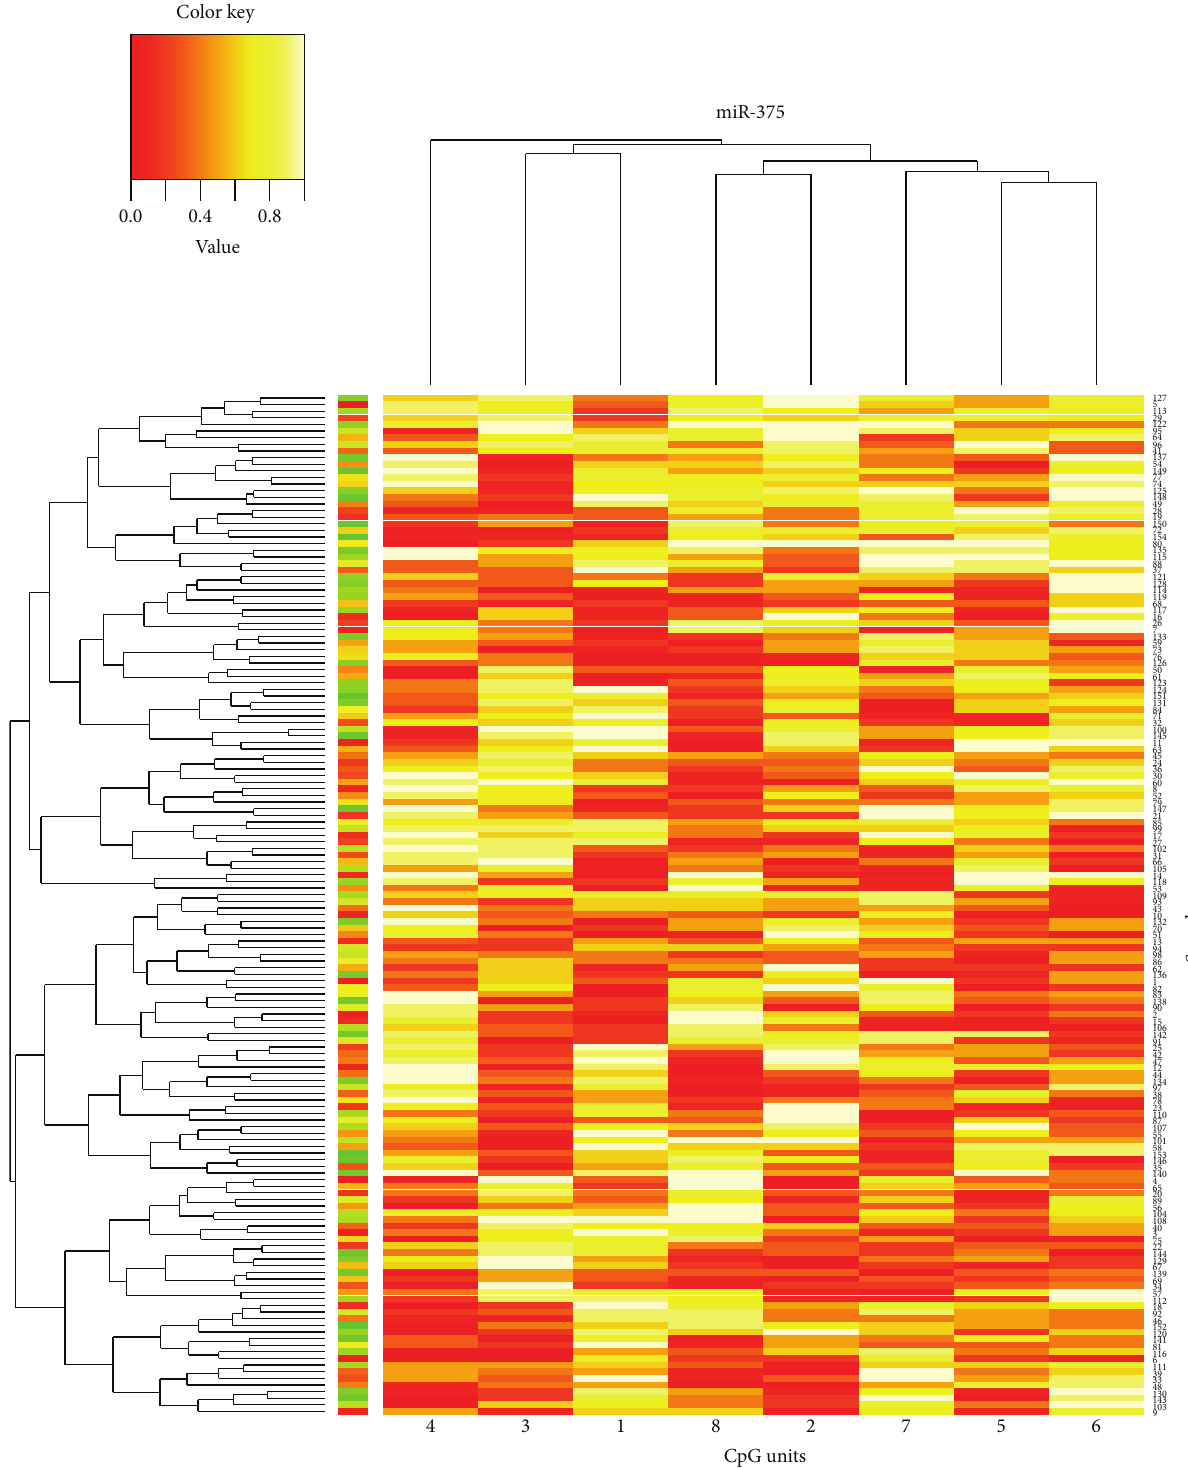
Figure 2: Hierarchical clustering of miR-375 methylation profiles in Kazak and Han T2DM samples. MassARRAY analysis quantified DNA methylation status of miR-375 gene promoter region in Kazak and Han T2DM samples. Each row represented a sample and each column represented a CpG unit, which was a single CpG site or a combination of CpG sites. Color coding reflected the degree of methylation with yellow being 100% red being 0%, and gray being no